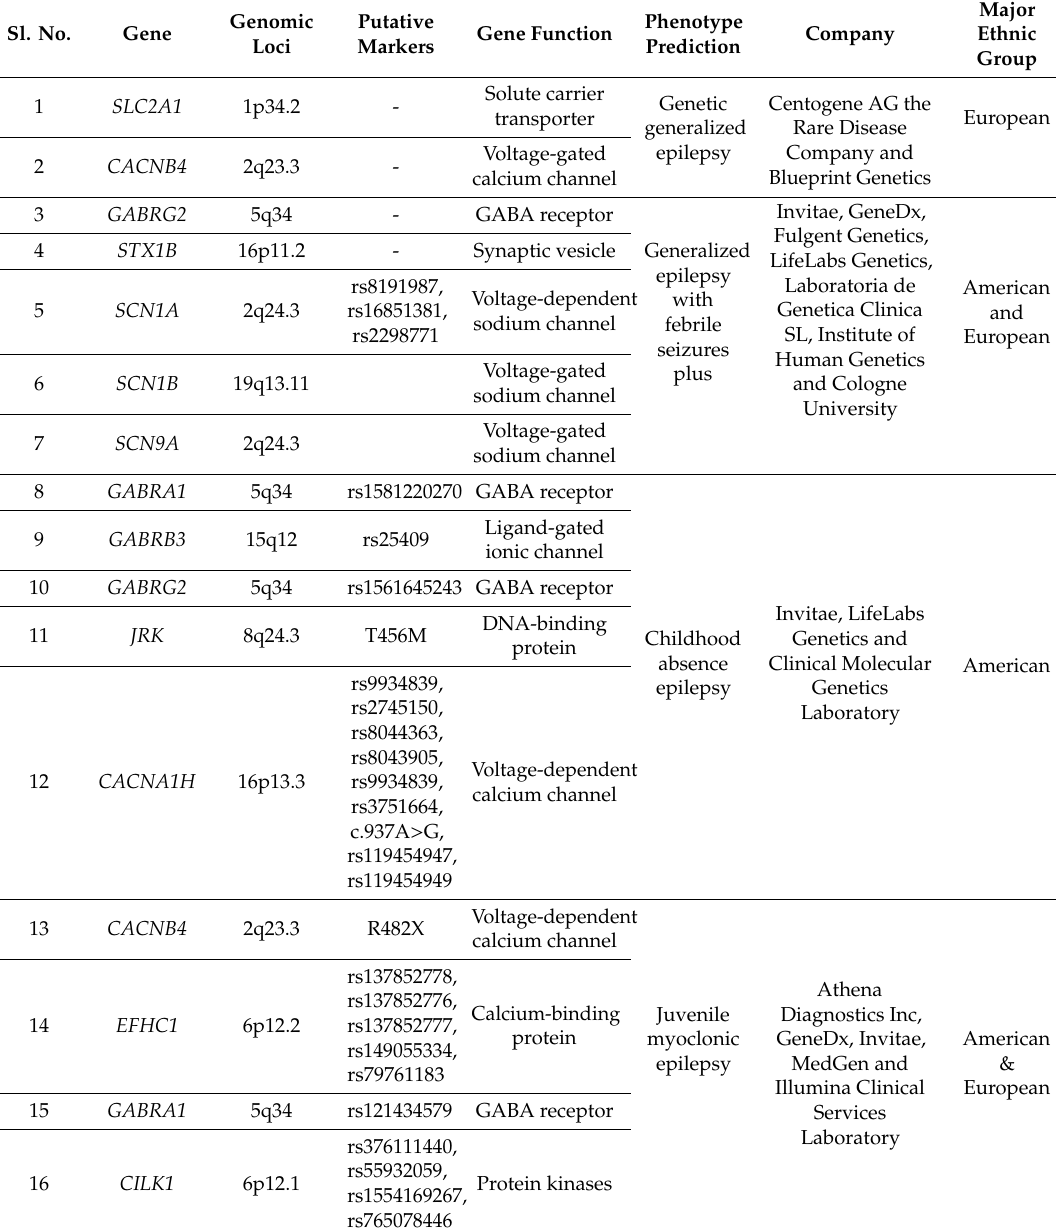
Table 3. List of available genetic diagnosis markers for common epilepsies. Sl.